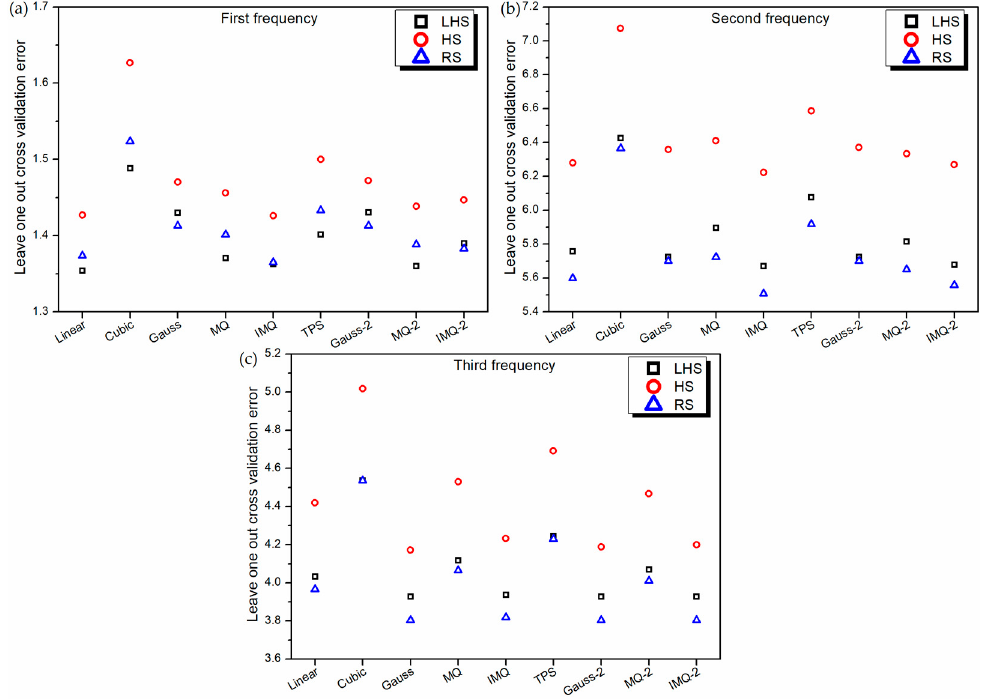
Figure 11. Leave-one-out cross-validation error of various RBF metamodels in